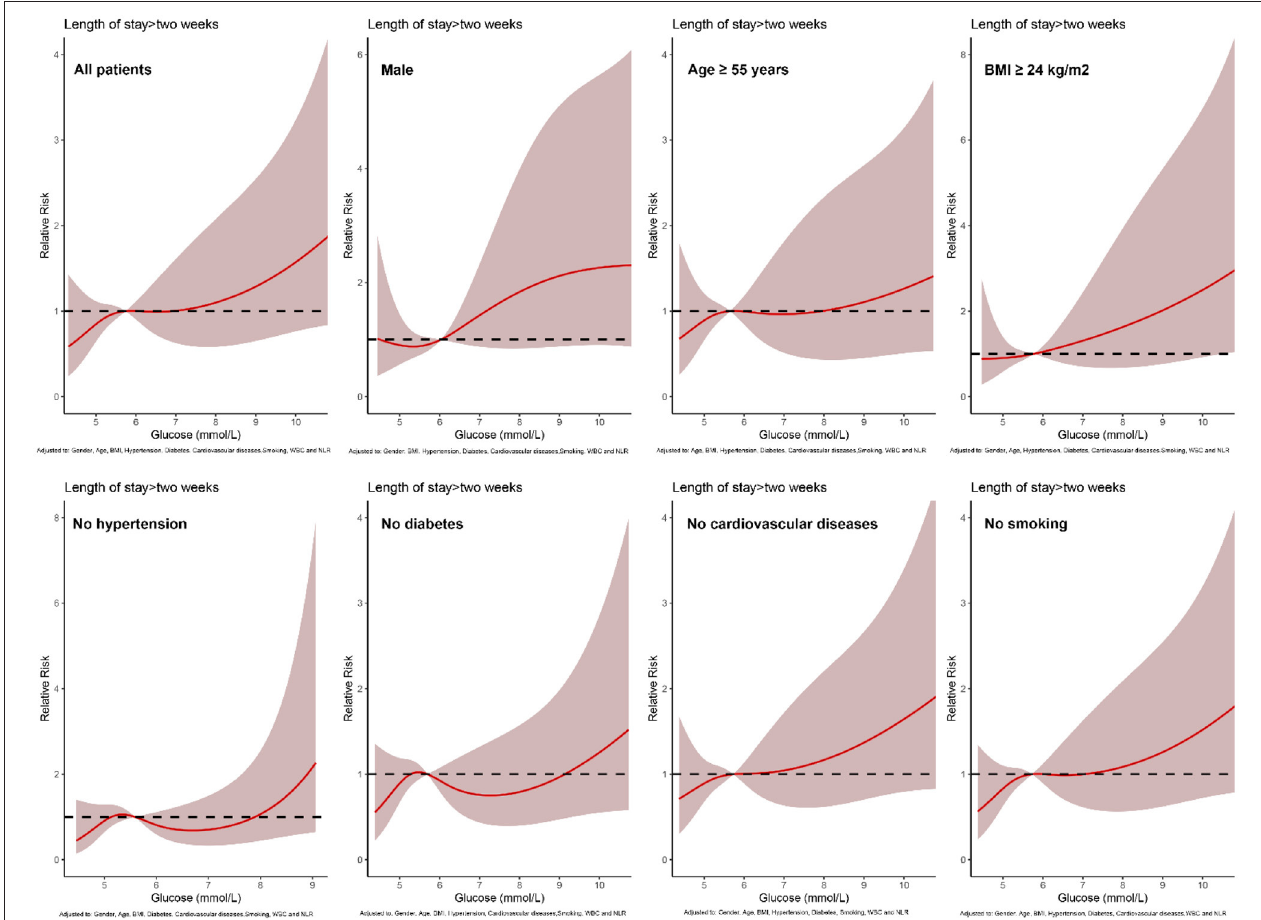
FIGURE 1 | Relative risk for a hospital LOS > 2 weeks based on POBG level. The solid black lines represent aORs according to restricted cubic splines for POBG level. The shaded areas represent upper and lower 95% CIs. Adjustment factors are as same as which presented in extended model of Table 3 .